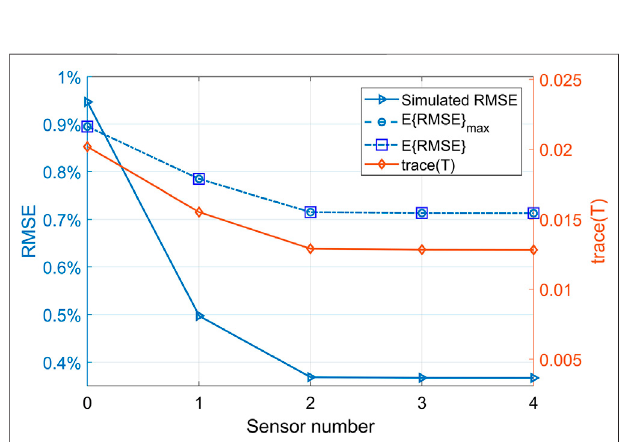
FIGURE 15 | RMSE and trace(T) vs. sensor number for optimal sensor